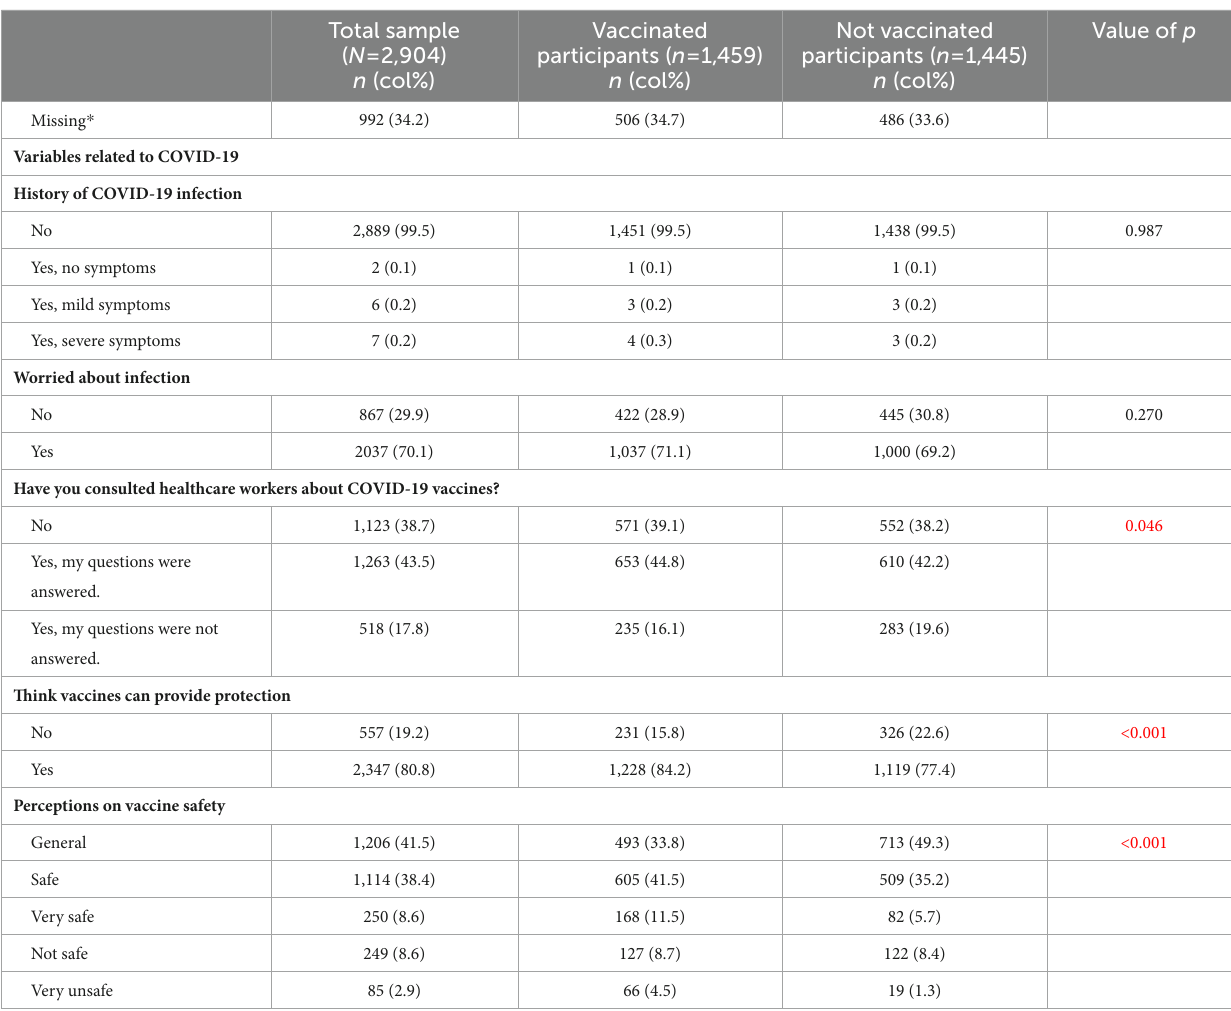
The side effect rates for each vaccine dose are illustrated in Figure 3. Of the 1,459 vaccinated participants, 186 (12.7%) reported side effects after the first dose, including 99 cases (6.8%) of fatigue, 66 cases (4.5%) of muscle pain, and 38 (2.6%) cases of allergic reaction. The most common side effect for the second dose was fatigue, accounting for 10.9% of 1,407 participants, while muscle pain (73/720, 10.1%) was the most common side effect for the third dose. Notably, breast discomfort, described as breast itching, tenderness, swelling, or pain, was reported by 0.3–0.6% of the participants. The side effect rates among different types of COVID-19 vaccines were significantly different for first and the third dose ( p = 0.007 and 0.019, respectively), whereas no difference was observed for the second dose ( p =